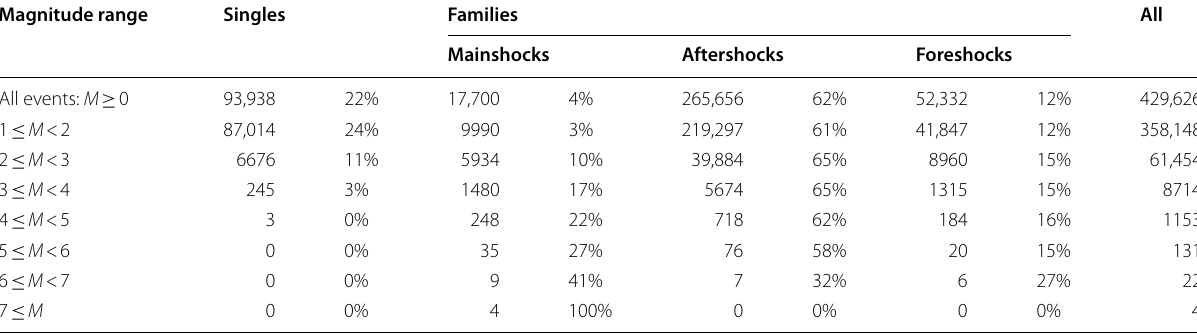
Table 2 Statistics of singles, mainshocks, aftershocks, and foreshocks using the nearest-neighbor distance analysis of long-term data Magnitude range Singles